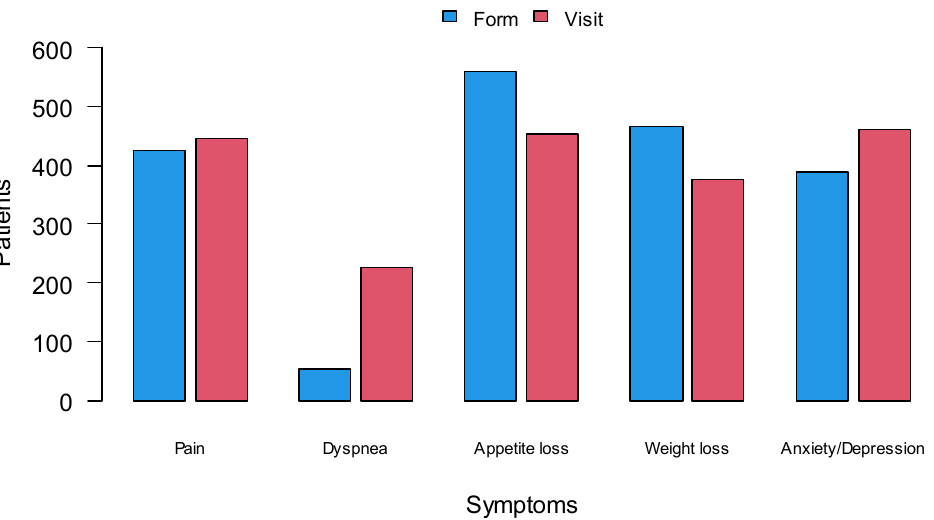
Figure A2. Comparison of symptoms recorded in referral form and during SCOC visit.